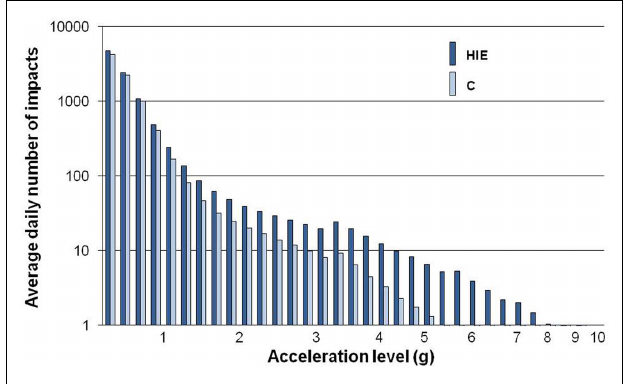
FIGURE 1 |The average daily distribution of impacts during the 12-month high-impact exercise intervention in premenopausal women. HIE, high-impact exercise group ( N = 34); C, control group ( N = 30). Modified from Jämsä et al.